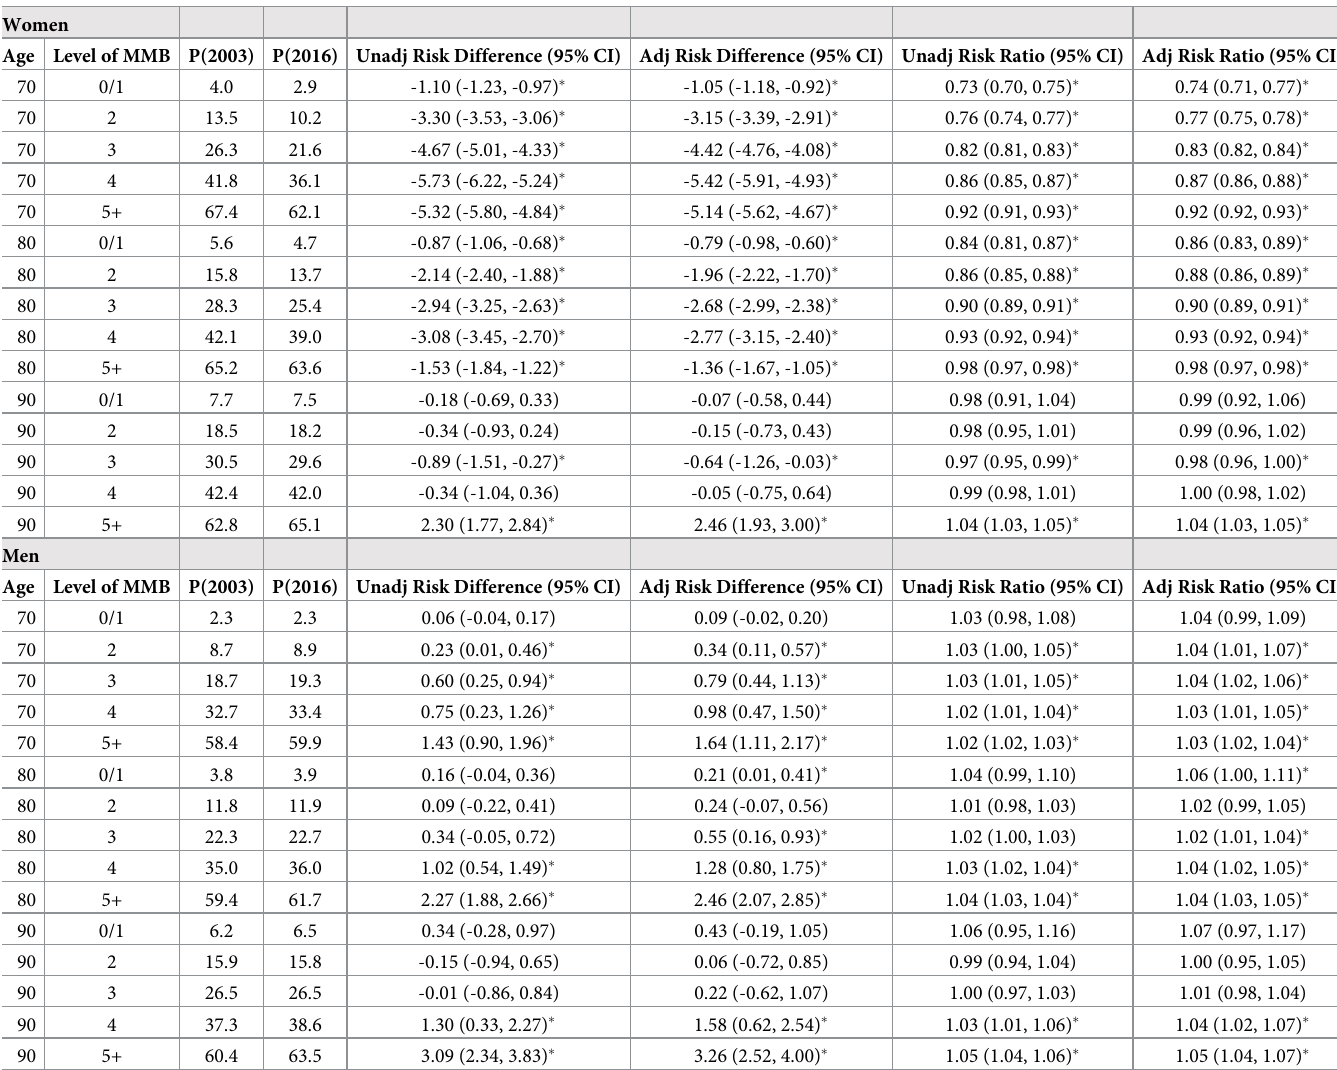
Table 3. Marginal probabilities of hyper-polypharmacy (10+ drugs) and unadjusted and adjusted risk differences and risk ratios (95% Confidence Intervals), by select ages, level of multimorbidity and sex.